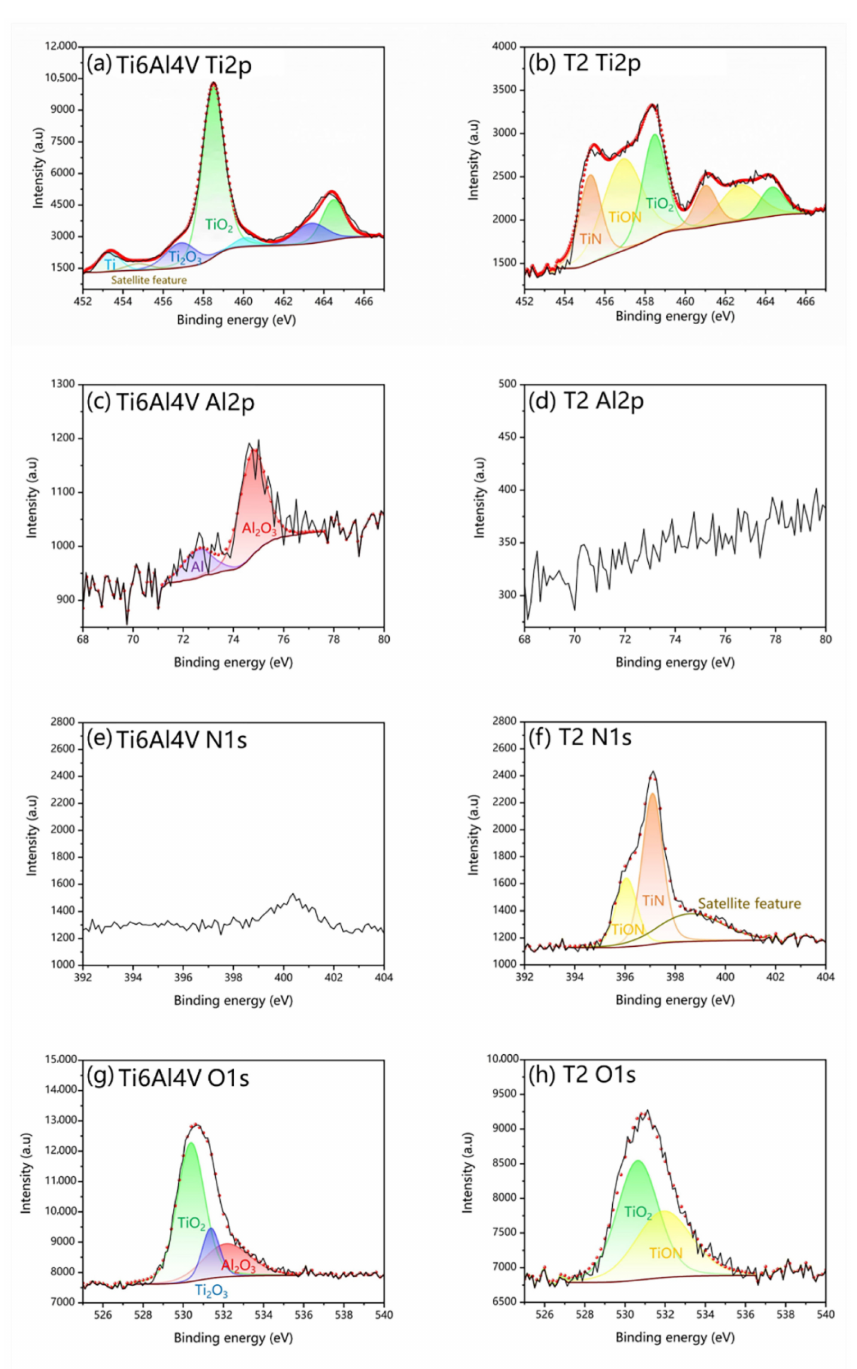
Figure 4. The XPS images of untreated Ti6Al4V: ( a ) Ti 2p, ( c ) Al 2p, ( e ) N 1s, ( g ) O 1s; and T2 samples: ( b ) Ti 2p, ( d ) Al 2p, ( f ) N 1s, ( h ) O